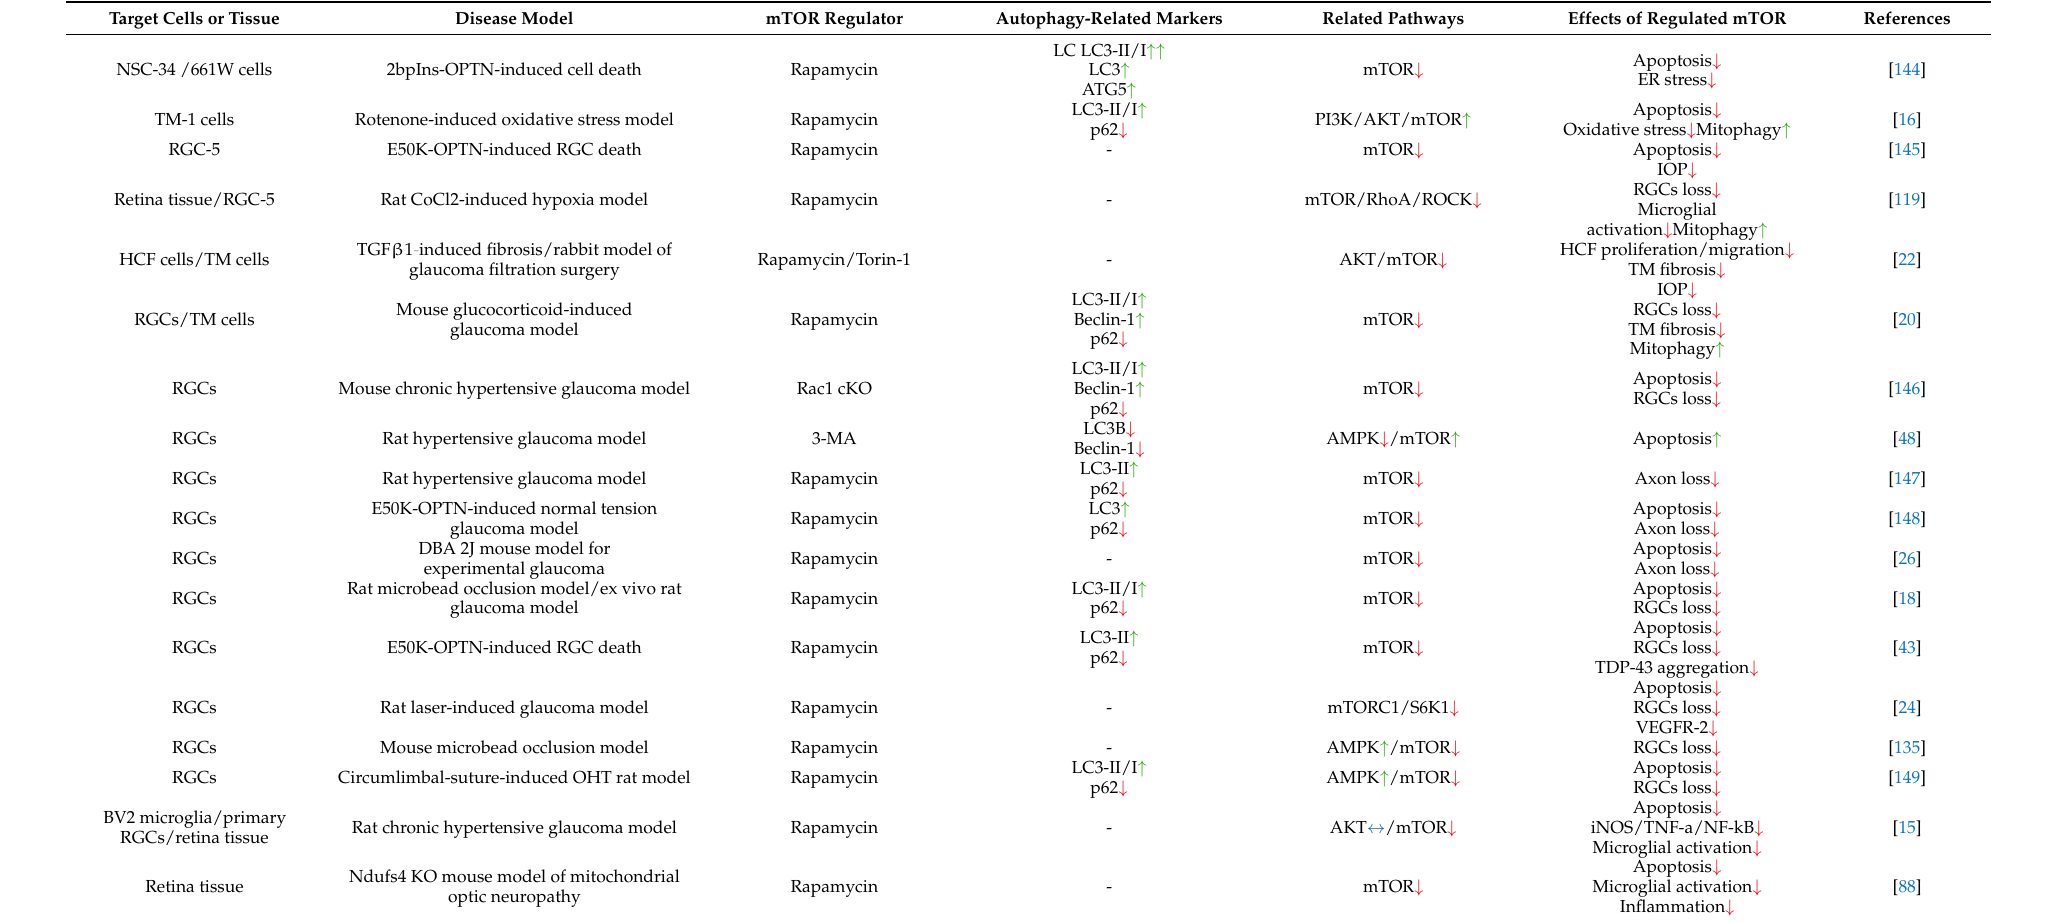
Table 4. Involvement of mTOR in glaucoma: in vitro and animal